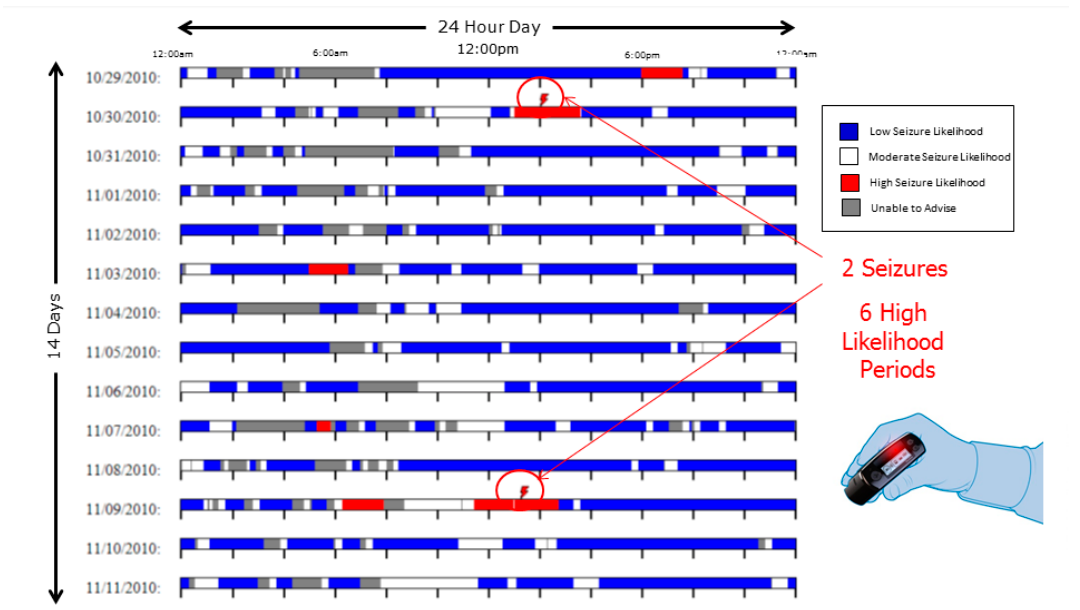
Figure 6. Advisory Timeline over 14 day contiguous block. Each of the 14 horizontal rows represents a continuous 24 h period. Each day-long row is a raster plot comprising columns of pixels, each column representing 2.3 min duration and comprising a vertical series of pixels, each pixel representing 13.8 s. In this time Advisory Timeline block, the patient had two seizures, each of which occurred within a “High Likelihood” (red indicator) advisory, of which there were six in this 14 day period. In Figure 7, a separate data set extending across 19 contiguous days also demonstrating 100% sensitivity.